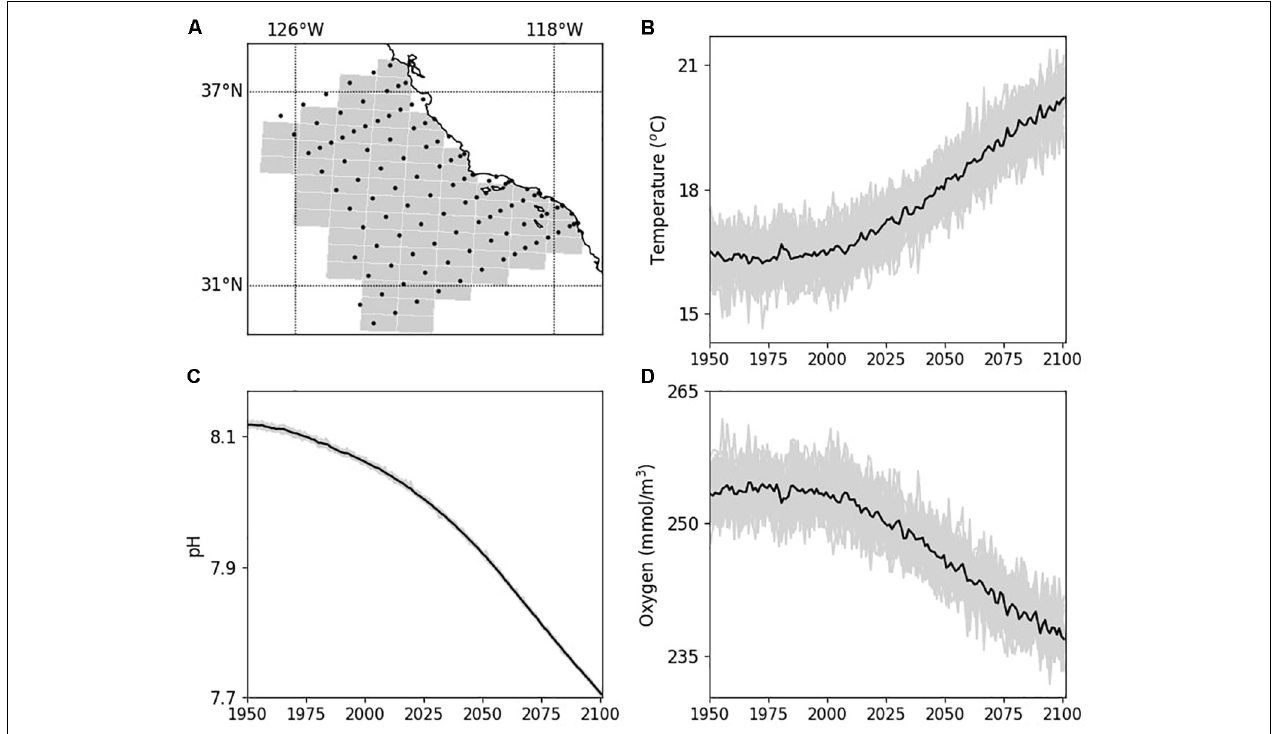
FIGURE 3 | End of twenty-first century climate projections for the CalCOFI region (A) for annual mean sea surface temperature (B) , surface pH (C) , and surface oxygen concentration (D) forced using RCP 8.5 “business as usual” emissions scenario. For the time-series, gray lines are individual model realizations (35 for temperature and 29 for pH and O 2 ) while the black line is the average of all model realizations. Climate model output obtained from the Large Ensemble Community Project (LENS) (Kay et al., 2015) for shaded grid cells in (A)